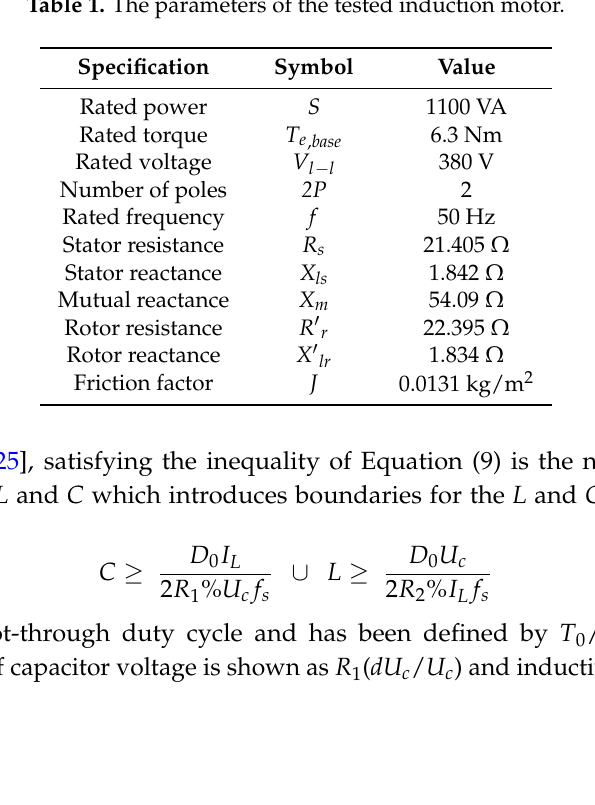
Figure 3. Variation of Z-source elements ( a ) voltage transfer ratio via C and L ; ( b ) minimum tracking value of L and C . Table 1. The parameters of the tested induction motor.